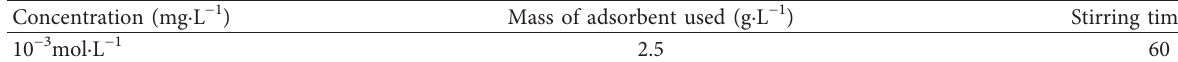
Table 7: Operating conditions of the tests studying the effect of the pH.